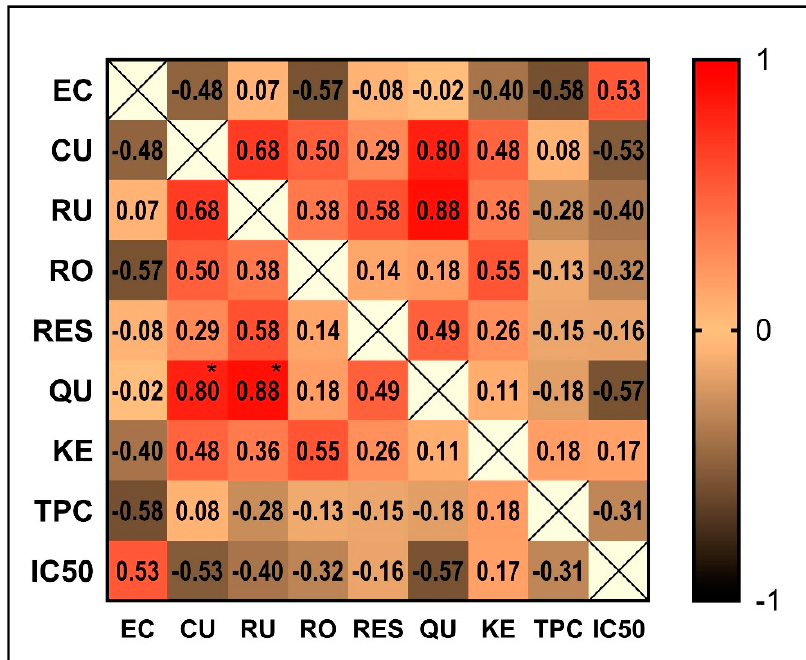
Figure 9. The inter-sample correlation matrix (* p < 0.05). (EC-epicatechin, CU- p -coumaric acid, RU-rutin, RO-rosmarinic acid, RES-resveratrol, QU-quercetin, KE-kaempferol, TPC-total phenolic content). Molecules 2019 , 24 , x FOR PEER REVIEW 11 of 20